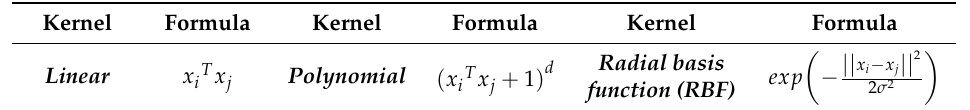
Table A2. The applied kernels in SVM.